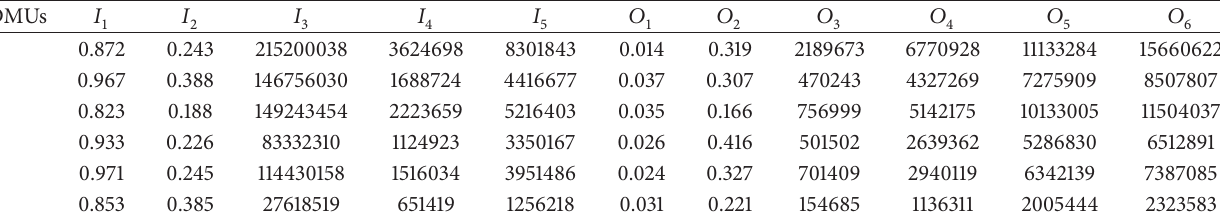
Table 5: Inputs and outputs (2009).